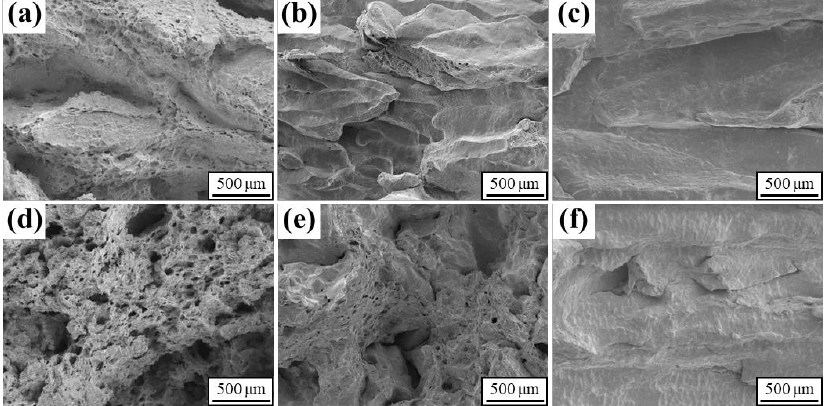
Figure 4. FE-SEM images of fracture surfaces; ( a , d ) Steel ref, ( b , e ) Steel A, and ( c , f ) Steel B at ( a – c ) at T T = 800 °C and ( d – f ) T T = 900 °C.